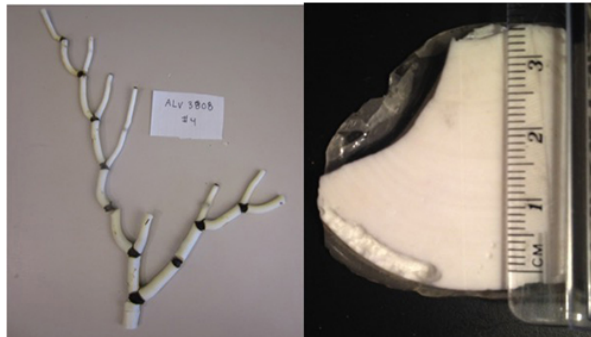
Figure 2. (a) A bamboo coral from Warwick Seamount, ALV 3808- 4. The bottommost internode is cut and the disk used for milling along the outer, most recently accreted portion. (b) A portion of a radial disk from PV 703-5 in which samples were milled from the center and outer